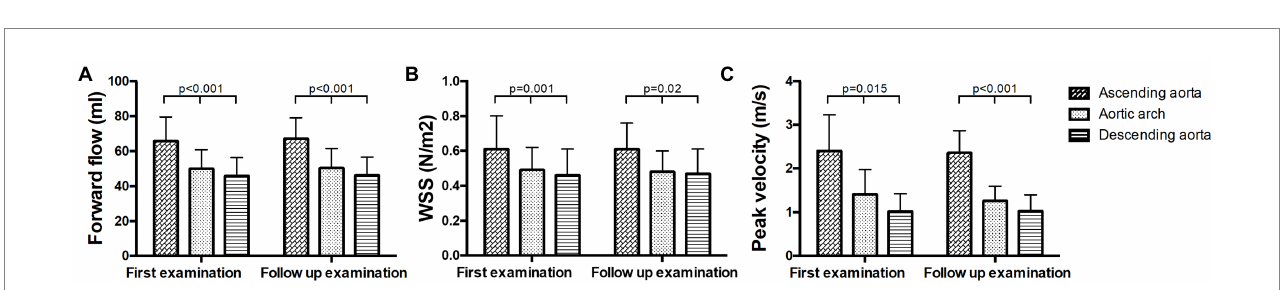
FIGURE 4 Hemodynamic measurements in the ascending aorta, the aortic arch and the descending aorta at baseline and follow up. (A) Forward flow volumes, (B) WSS, and (C) peak velocity.